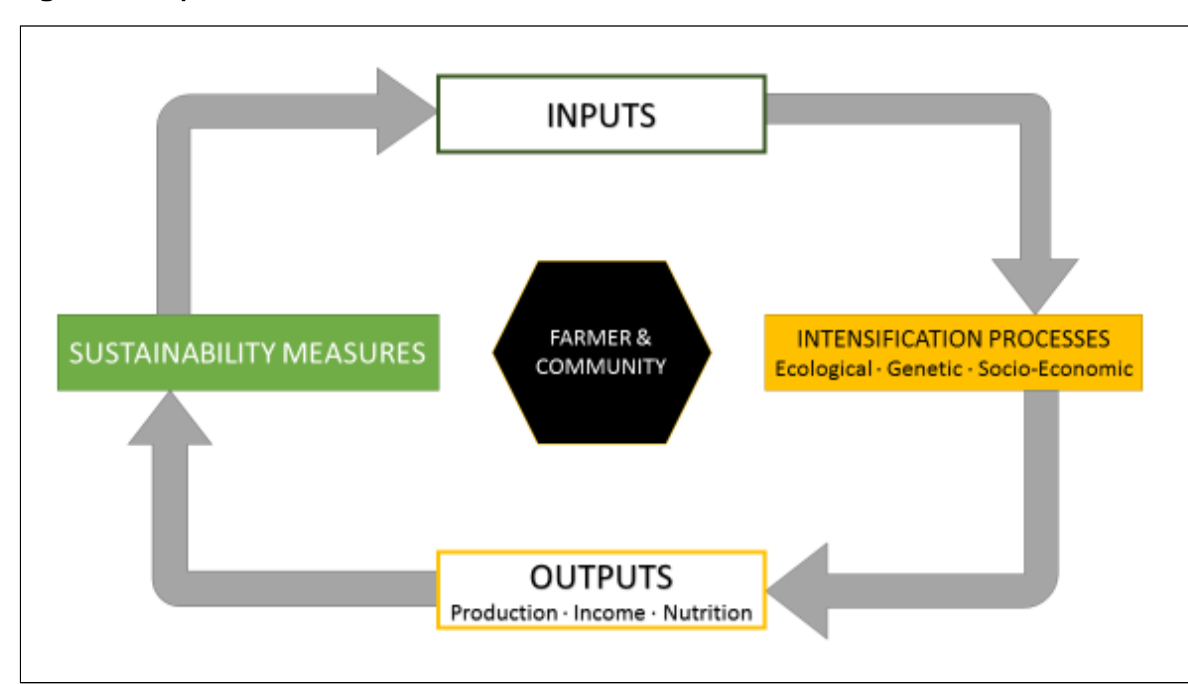
Figure 1. Montpellier Panel Theoretical Model of Sustainable Intensification